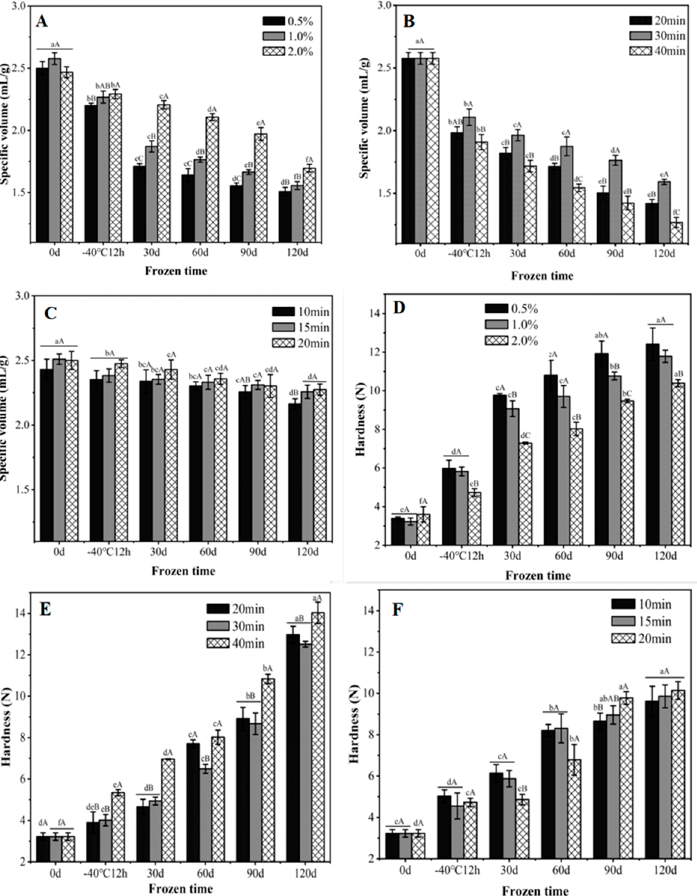
Figure 1. Effects of frozen storage on the specific volume and hardness of steamed buns made from unfermented frozen dough with yeast additions of 0.5%, 1.0% and 2.0% ( A , D ); pre-fermented frozen dough with the pre-fermented time of 20, 30 and 40 min ( B , E ); the par-steamed frozen dough with the pre-steamed time of 10, 15 and 20 min ( C , F ). Data with different lowercase and uppercase letters indicate the significant differences among the frozen dough with different storage time and different processing variables, respectively ( p < 0.05).